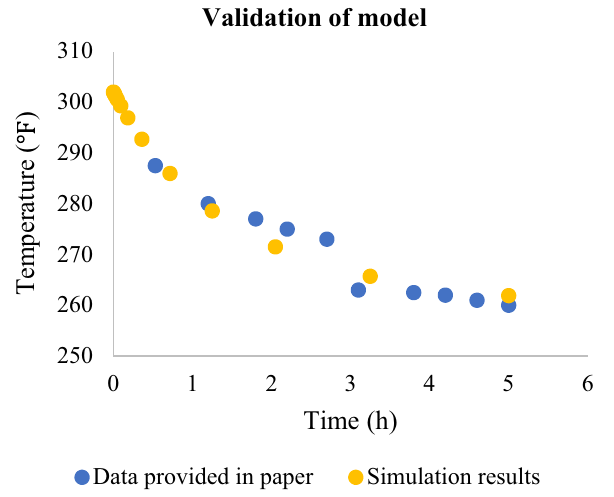
Fig. 11 Ax cutter nodes used for the analysis (yellow point indicates